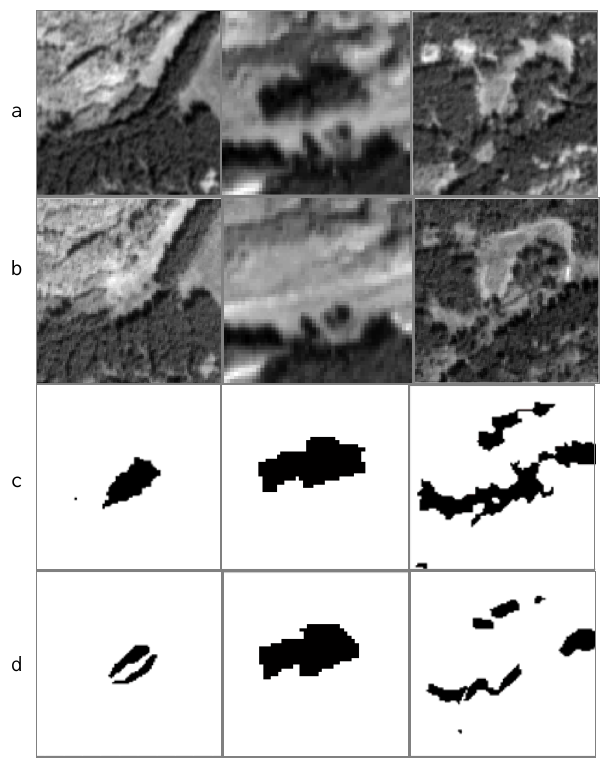
Figure 8. Parts of the change detection result (a: Pan-2008; b: Pan- 2009; c: Region based change detection results; d: Ground